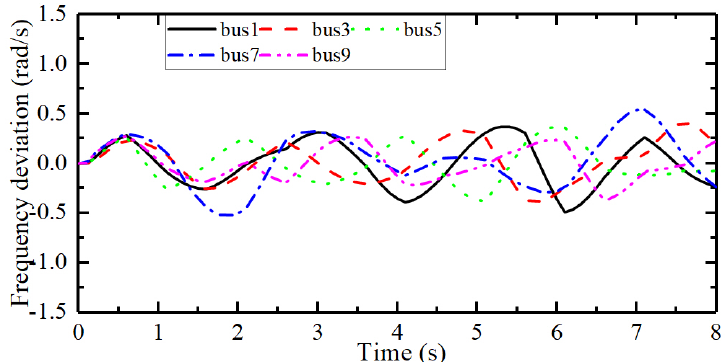
Figure 5. Frequency deviation of the bus without ADES controller.